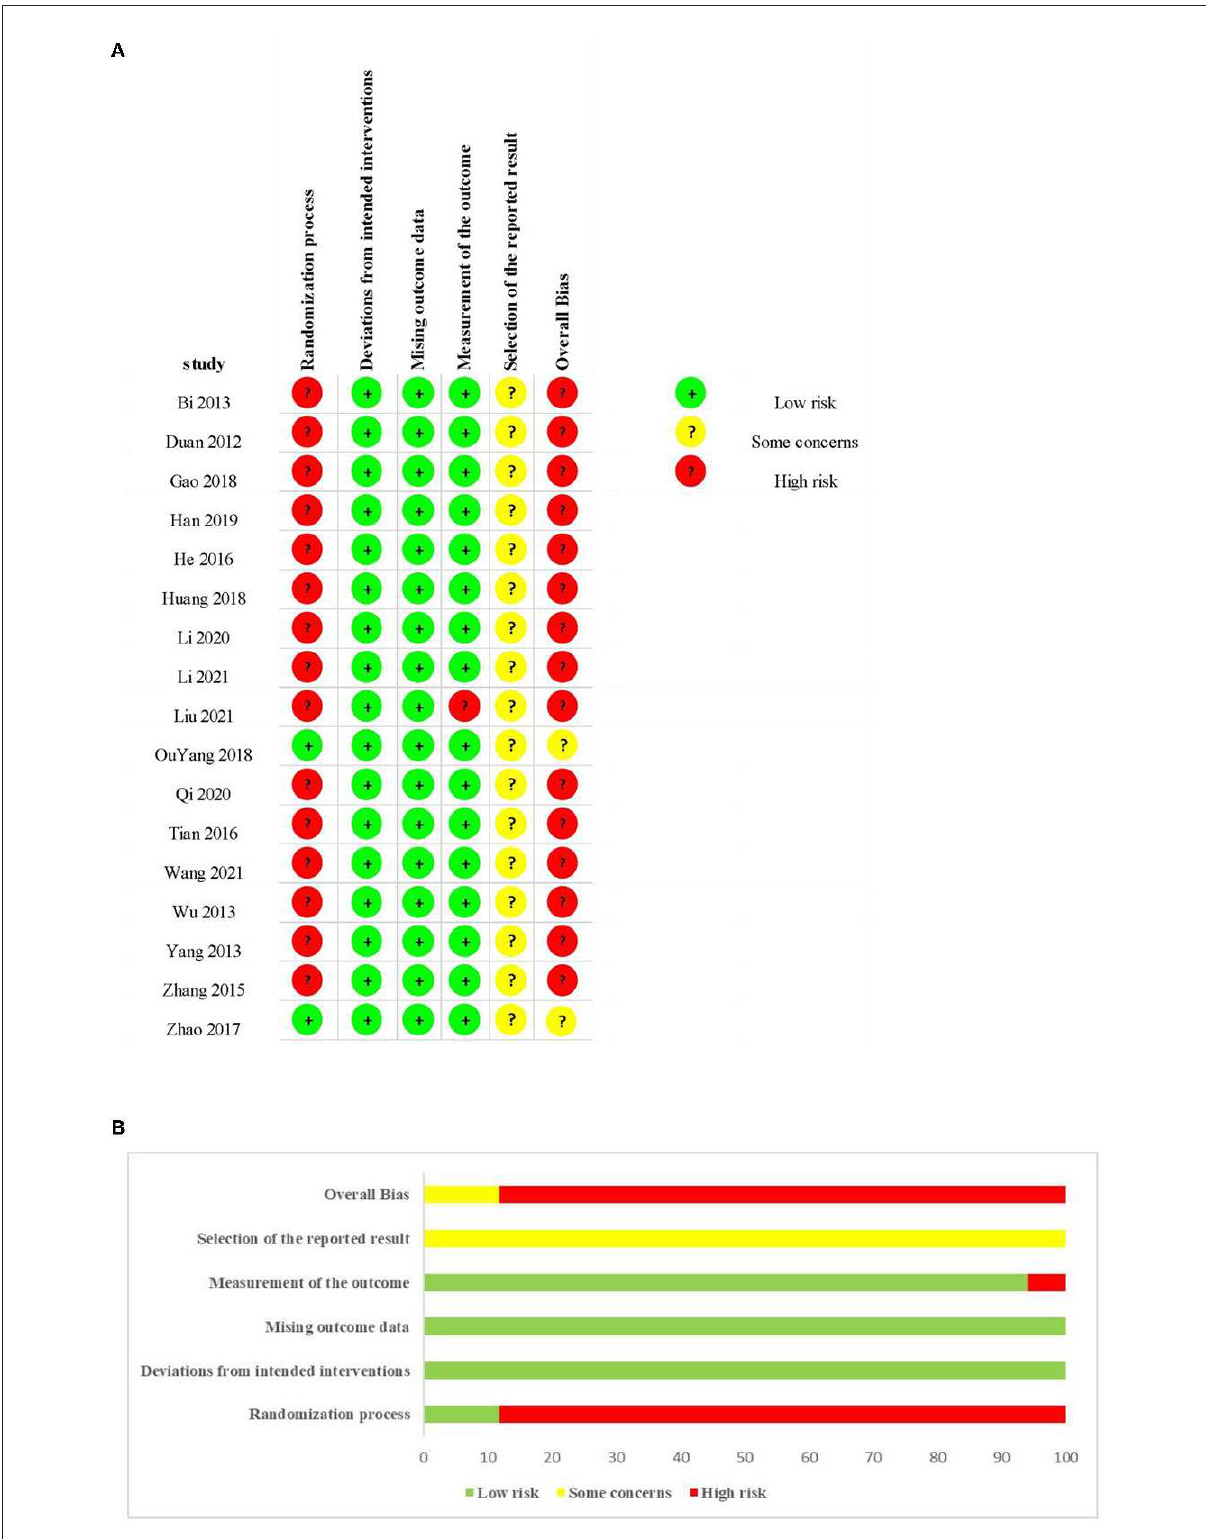
FIGURE2 Assessment of risk of bias (ROB2) using the Cochrane tool. (A) ROB graph and (B) ROB